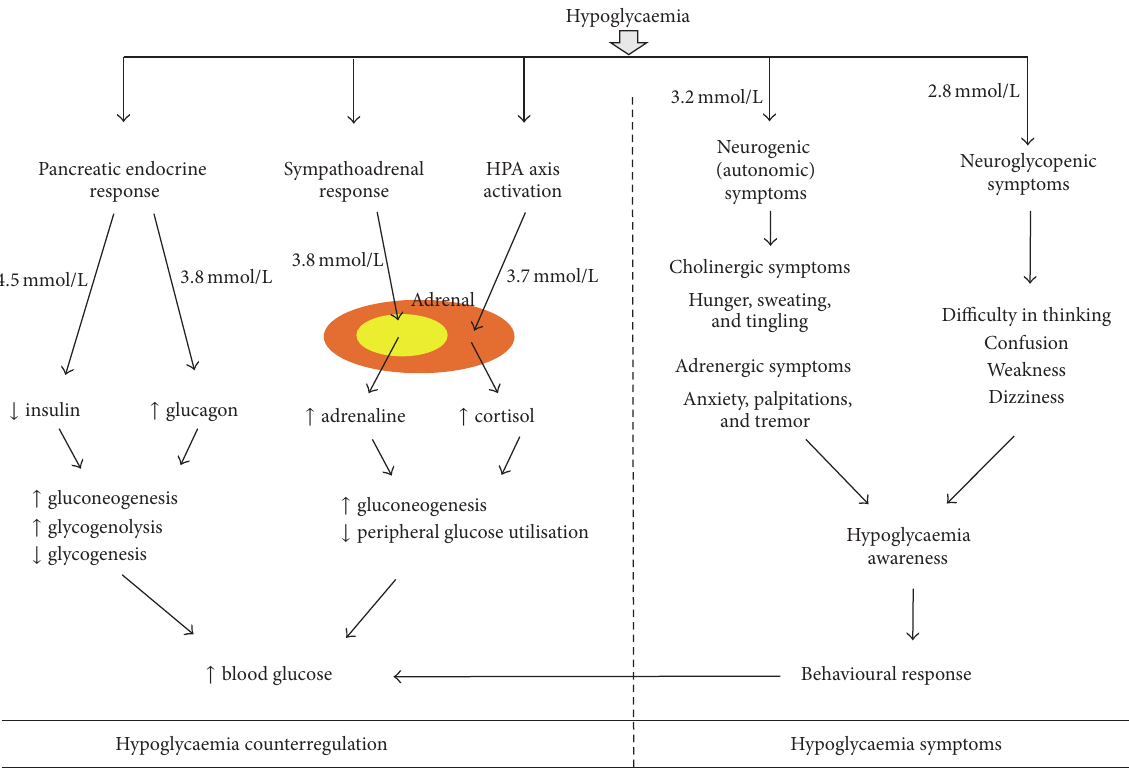
Figure 1: Counterregulatory and symptomatic responses to hypoglycaemia in nondiabetic humans. HPA axis: hypothalamic-pituitary- adrenal